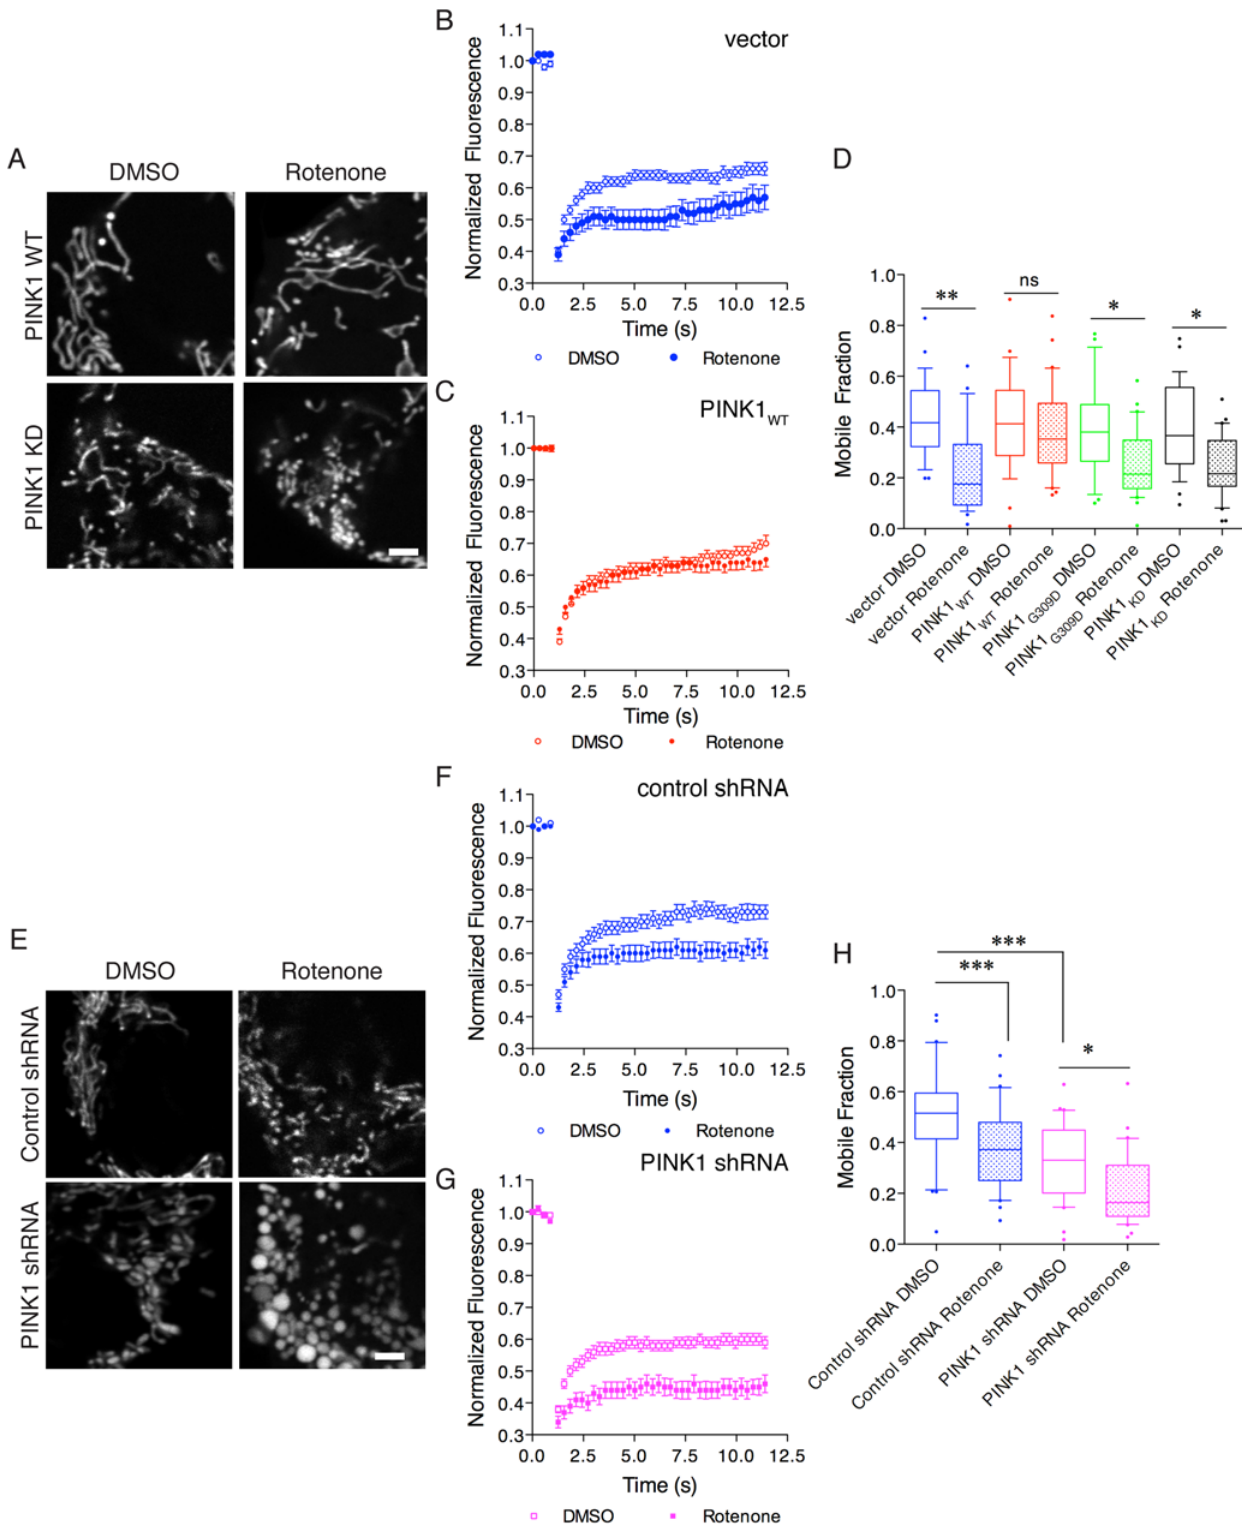
Figure 3. PINK1 protects against rotenone-induced loss of mitochondrial connectivity. (A) Living cells were imaged after transfection with mito-YFP. Cells expressing PINK1 had longer mitochondria compared to control lines (kinase dead shown here). Rotenone induced fragmentation in control lines but not in lines expressing PINK1. Scale bar in the lower right panel is 2 m m, applies to all fluorescence micrographs. (B) FRAP curves demonstrate that control cells showed more recovery under control conditions (open circles) than after 24 h exposure to 100 nM rotenone (closed circles). In this experiment, control cells are parental M17 cells that were transfected only with the mito-YFP vector to image mitochondria (labeled vector). (C) In contrast, cells stably transduced with wild-type PINK1 showed very similar FRAP curves whether this was measured in the presence of